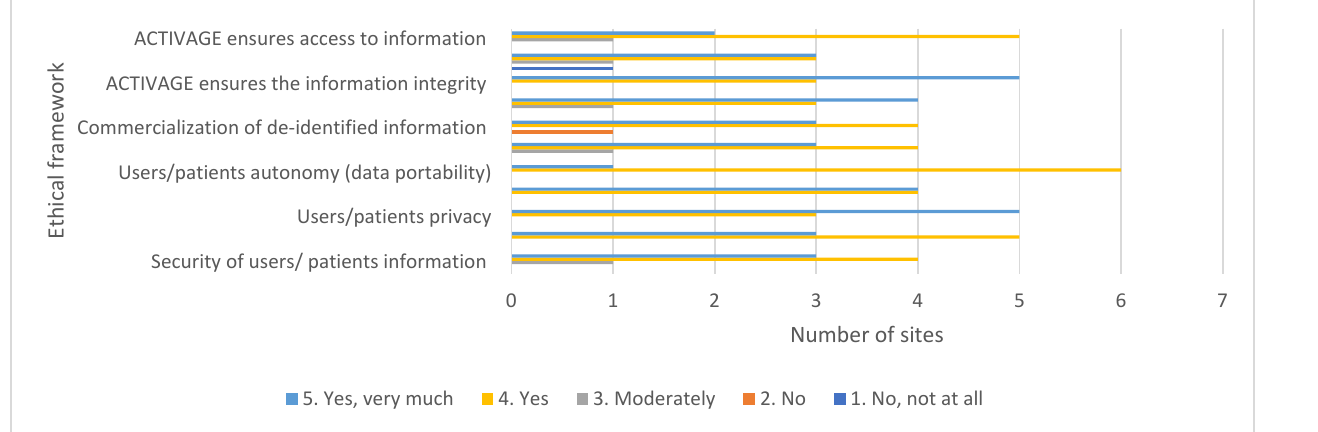
Figure 10. Final evaluation of ACTIVAGE Ethical Framework.